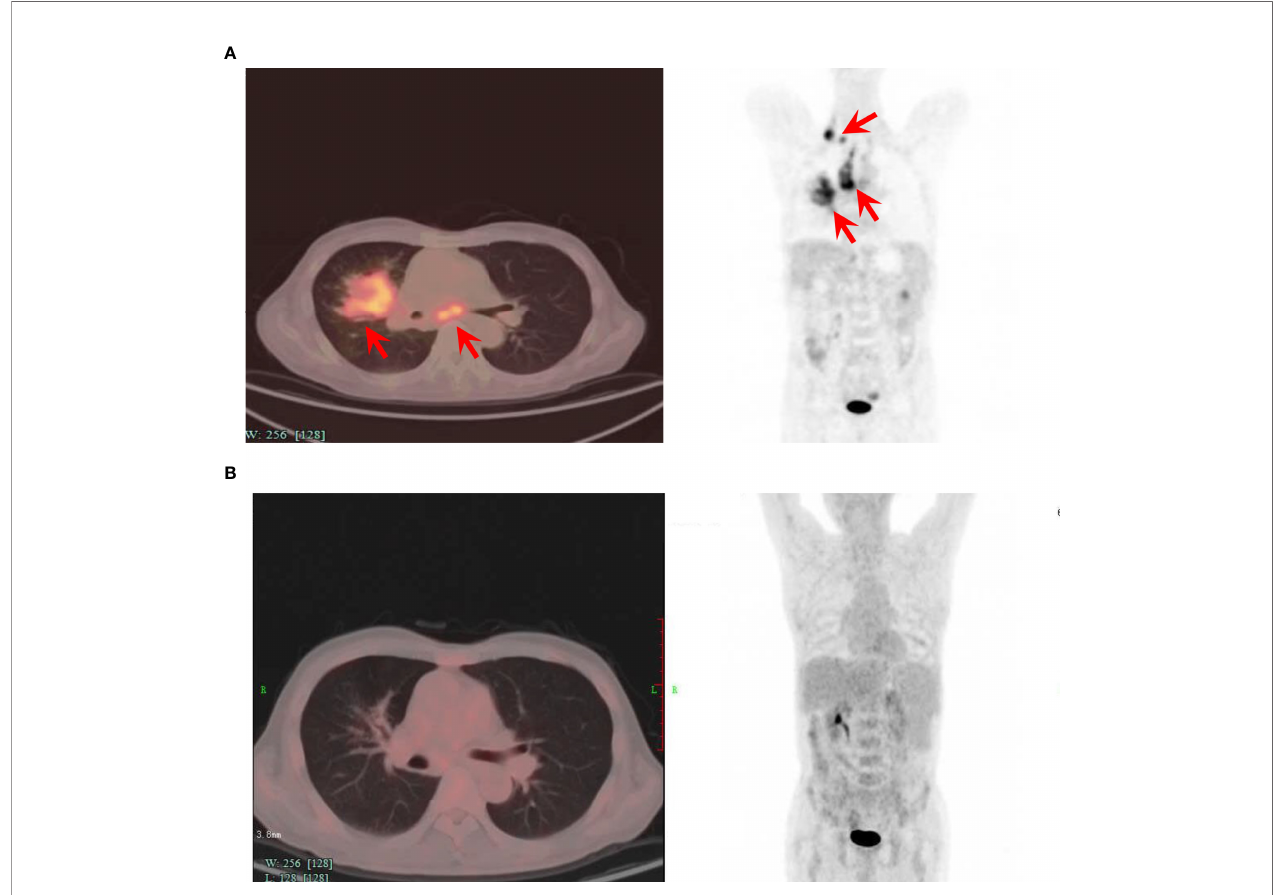
FIGURE 1 | Positron-emission tomography-computed tomography before and 3 months after CAR-T cell infusion. (A) PET-CT image of the patient before the CAR- T cell infusion, showing lymphoma invasion. (B) PET-CT image of the patient 3 months after the CAR-T cell infusion, showing no lesions and complete remission. The axial image (left) and coronal image (right) are shown. Red arrows indicate lymphoma